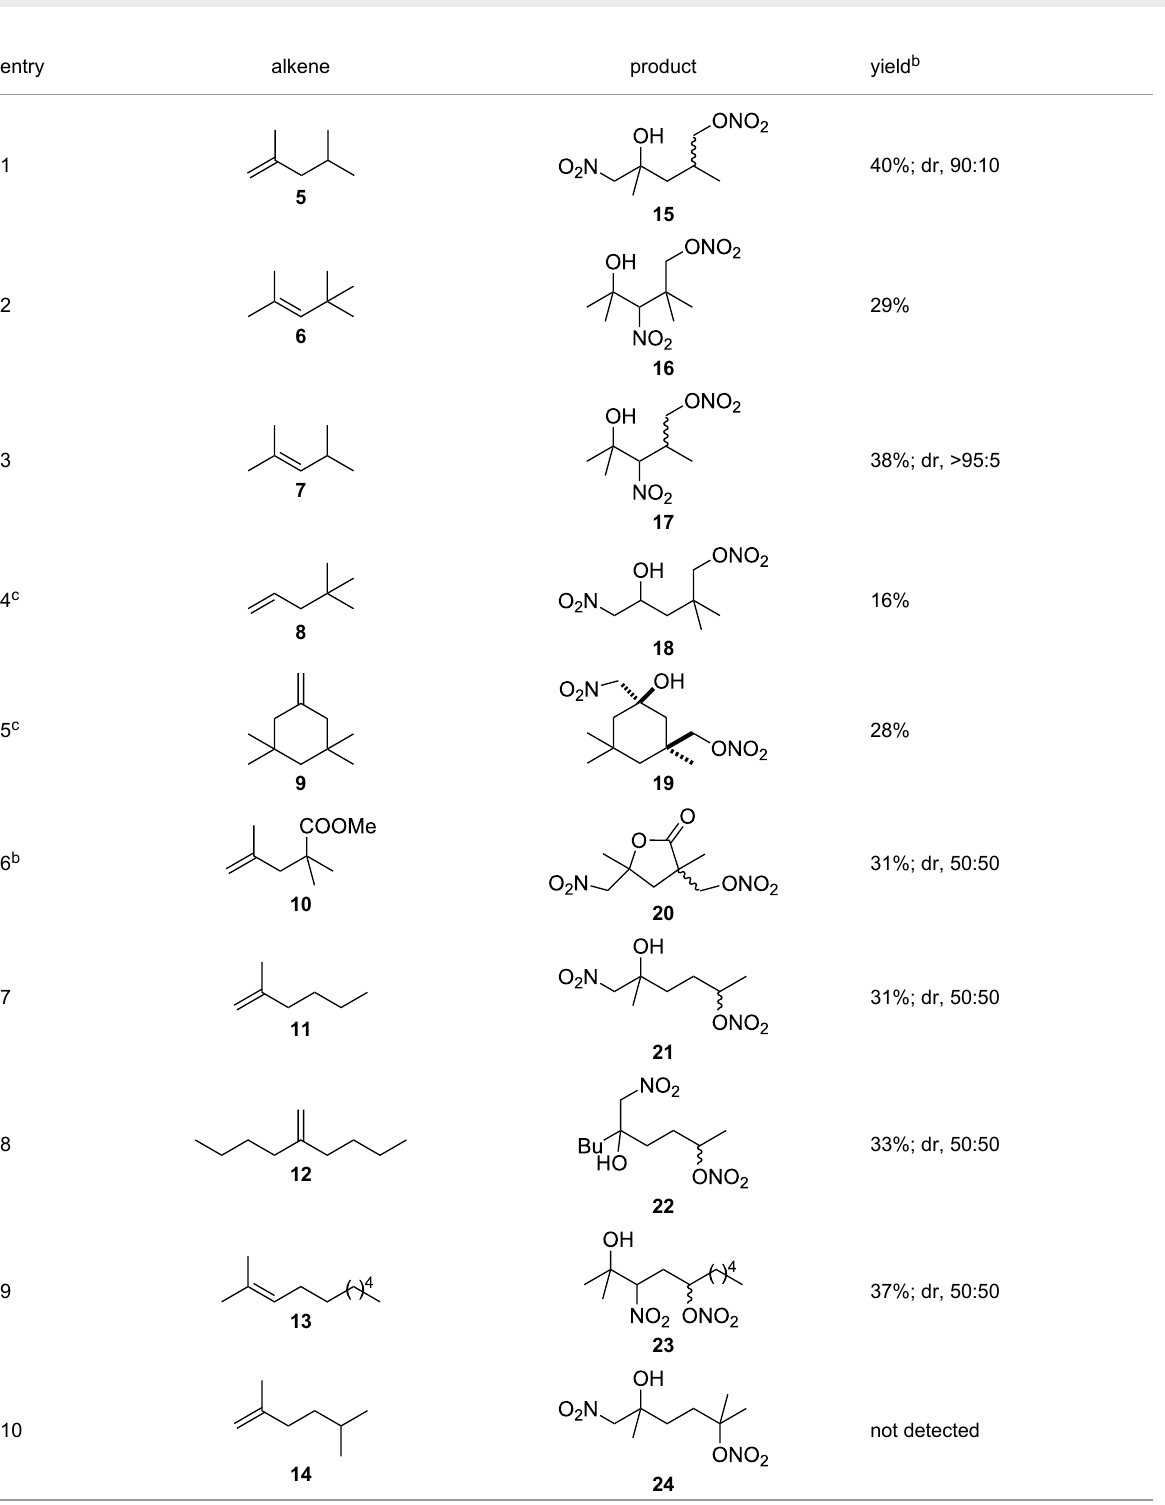
Table 2: Reactions of various alkenes a